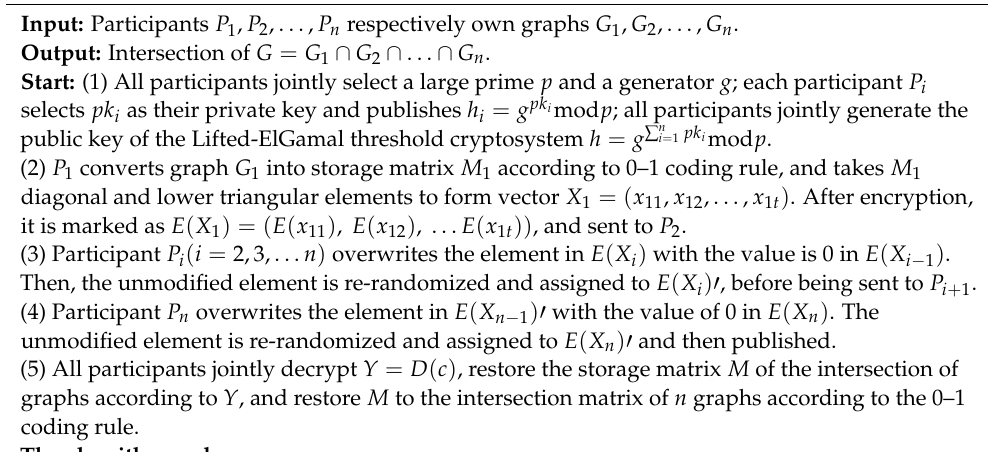
Algorithm 1. Graphs’ intersection MPC algorithm under the semi-honest model